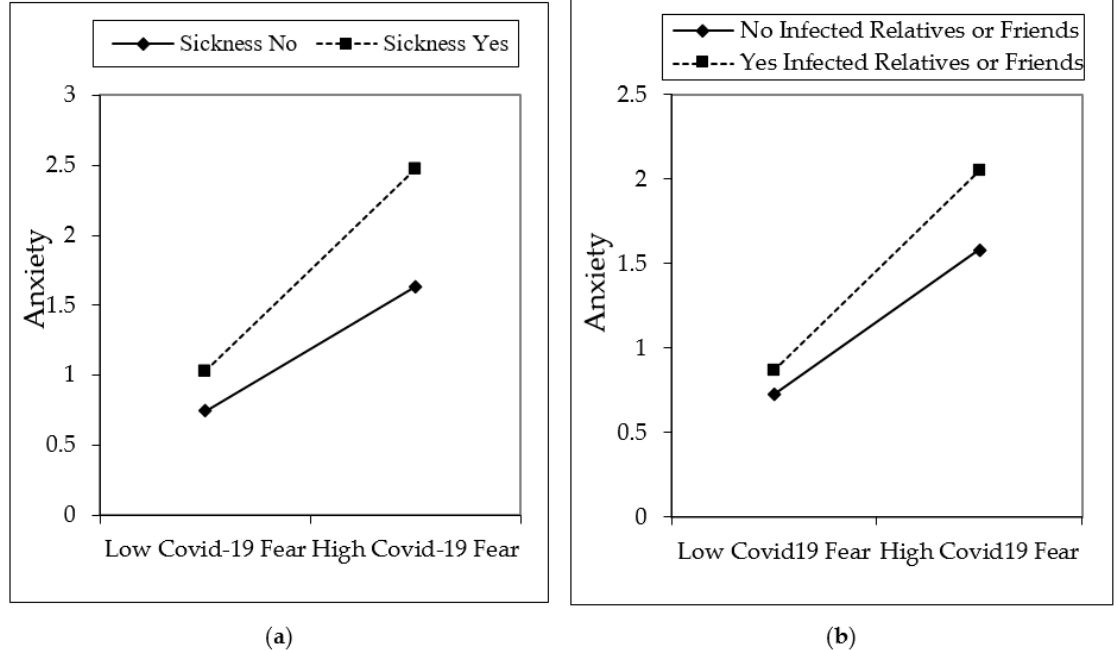
Figure 3. Interaction effects on anxiety. Moderators of underlying sickness is depicted in a, having infected relatives or friends is depicted in b.